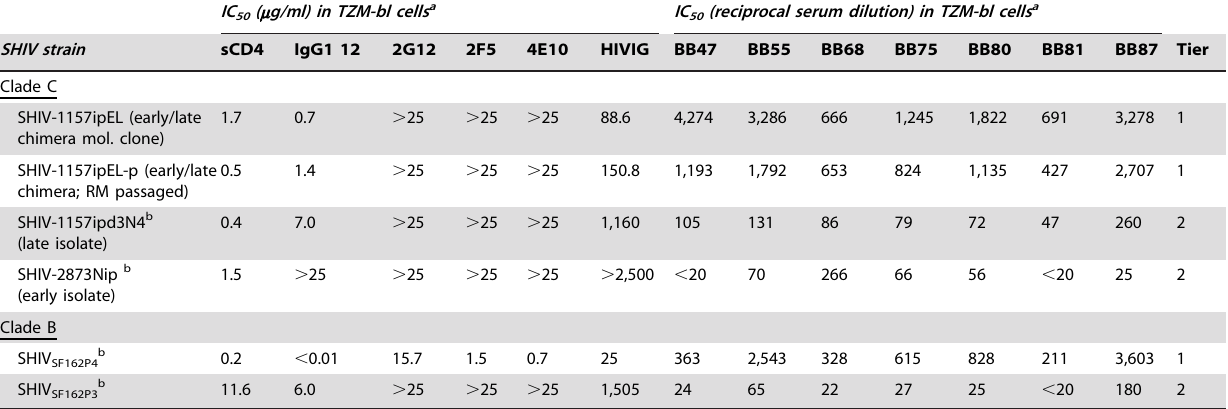
Table 2. Sensitivity of R5 SHIV strains to soluble CD4, human nmAbs and serum samples.